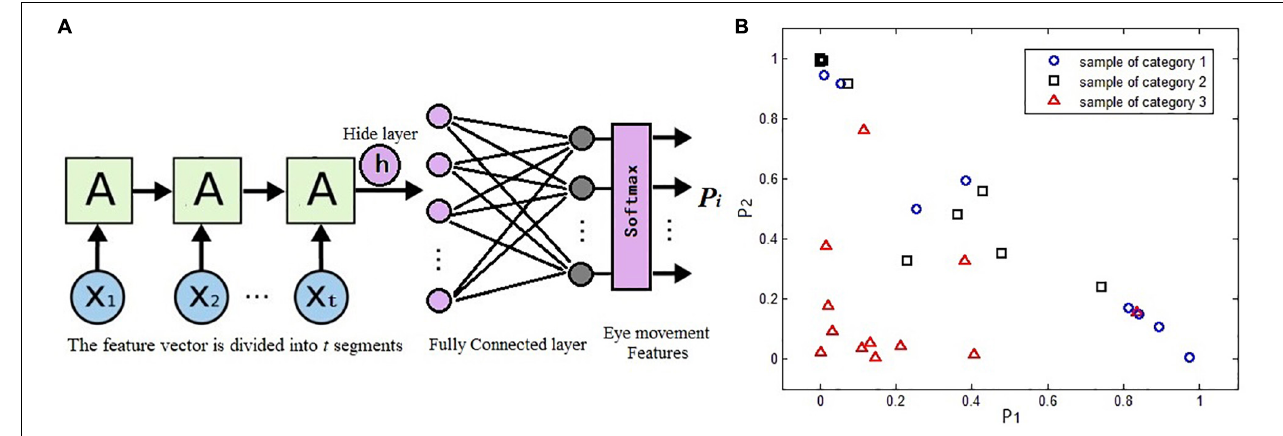
FIGURE 4 | Long short-term memory (LSTM) network classification results served as evolutionary eye movement features: (A) the LSTM classifier in our work and (B) sample distribution map based on evolutionary eye movement